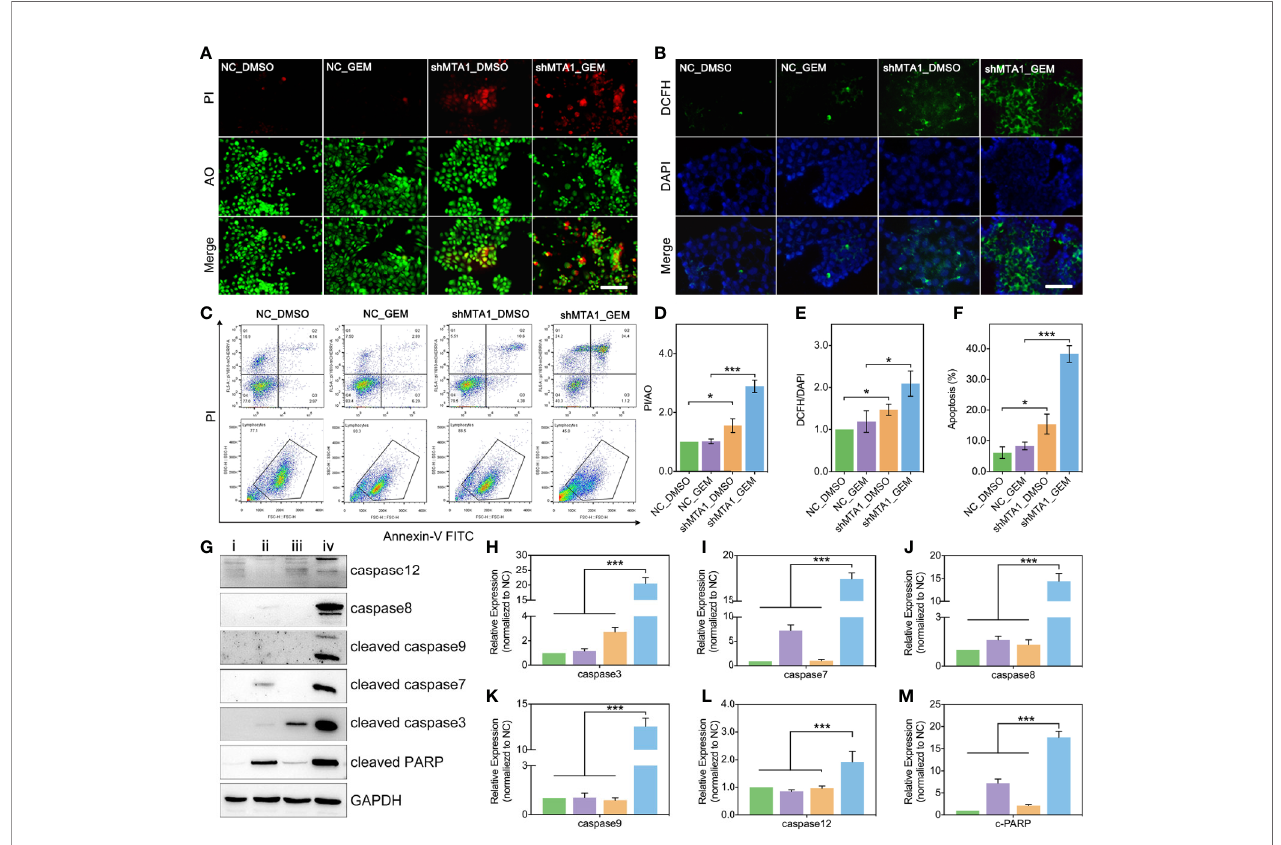
FIGURE 3 | MTA1 knockdown with gemcitabine treatment up regulated the ros-reaction and apoptosis in MCF-7 cells. (1) breast cancer cells (NC_MCF-7 or shMTA1_MCF-7) are planted in 24-well plates for 24h, followed by 48h-treatment of 5 m M gemcitabine or DMSO (4 groups: NC_DMSO, NC_GEM, shMTA1_DMSO and shMTA1_GEM), which are tested for live-death assay (live: green, death: red) (A, D) . (2) breast cancer cells (MCF-7 or shMTA1_MCF-7) are planted in 24-well plates for 24h, followed by 48h-treatment of 5 m M gemcitabine or DMSO (4 groups: NC_DMSO, NC_GEM, shMTA1_DMSO and shMTA1_GEM), which are tested for ros-reaction through ros probes (ros: green, DAPI: blue) (B, E) . (3) breast cancer cells (MCF-7 or shMTA1_MCF-7) are planted in 6-well plates for 24h, followed by 48h-treatment of 5 m M gemcitabine or DMSO (i: NC_DMSO, ii: NC_GEM, iii: shMTA1_DMSO, iv: shMTA1_ GEM), which are tested for apoptosis and WB assay (C, F – M)